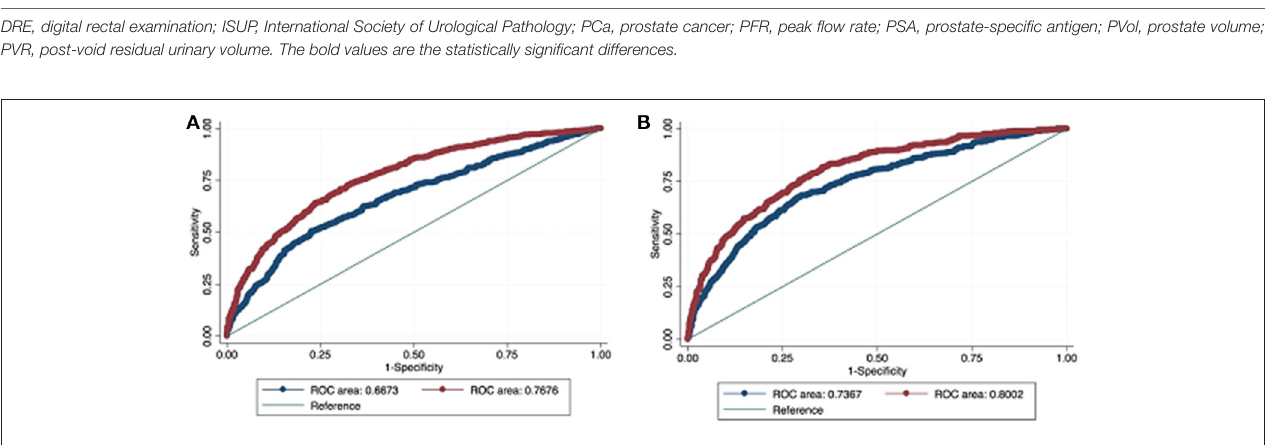
directly correlated to BPO and LUTS, is inversely correlated with the risk of harboring PCa in men scheduled for PBx (19,